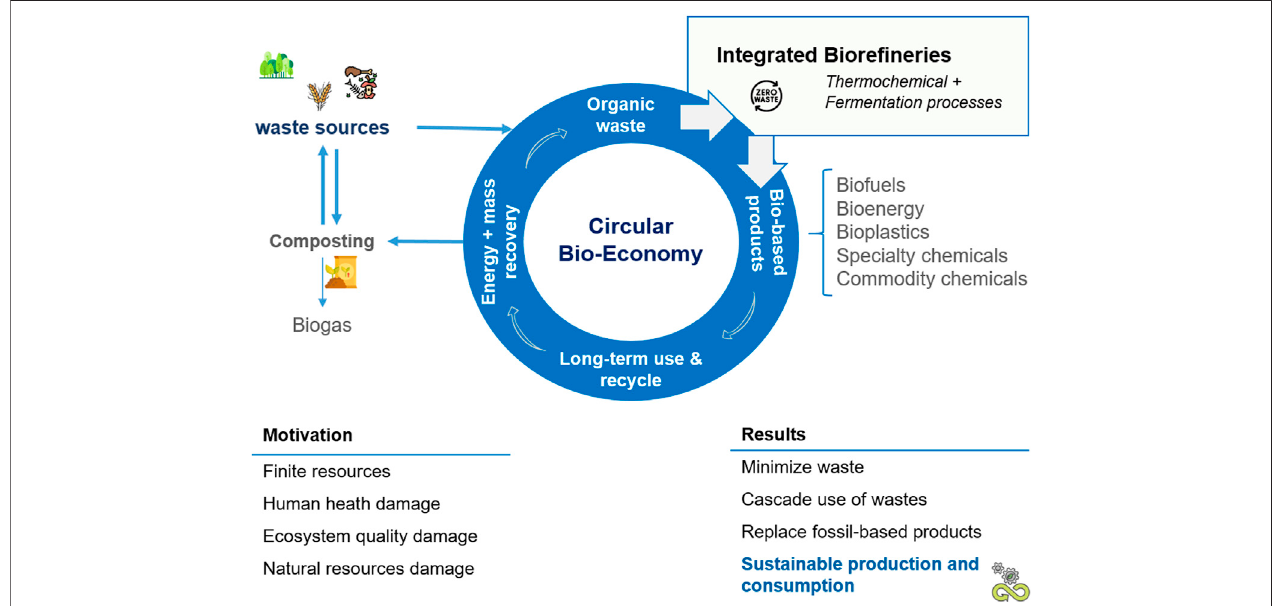
FIGURE 1 | Circular bioeconomy: motivation, strategy, and results. Symbols from www. fl aticon.com.